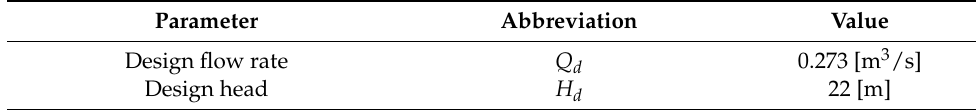
Figure 1. Structures of the large-scale vaned-voluted centrifugal pump model. Table 1. Main parameters and values of the pump